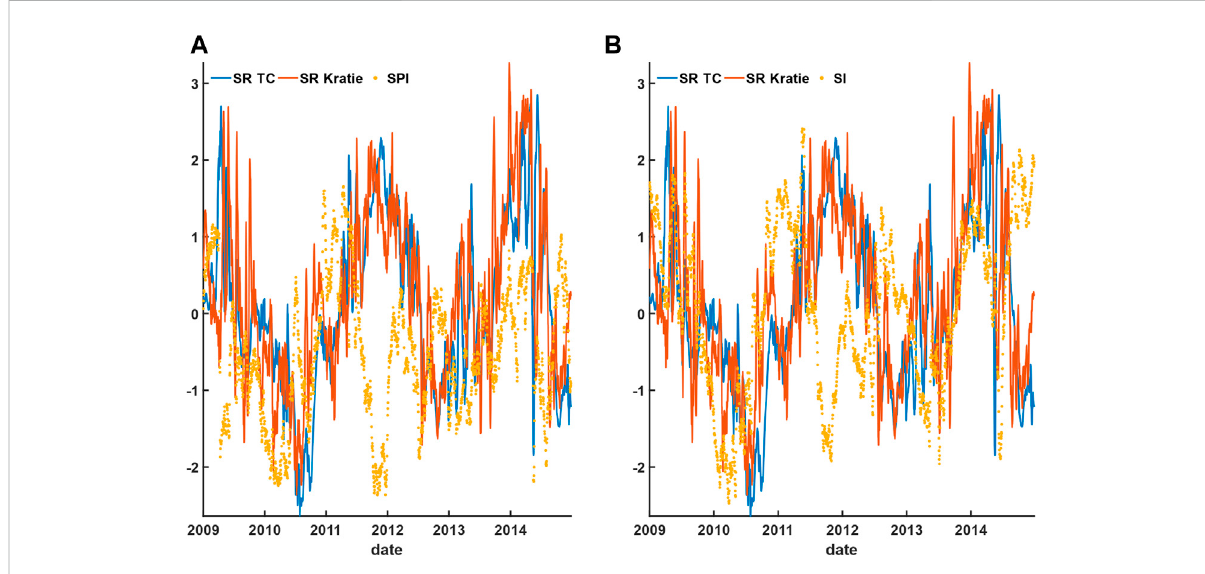
FIGURE 17 Upstream (A) SPI from GPM-TRMM and (B) SI from GRACE against the standardized runoff at the TC-CD